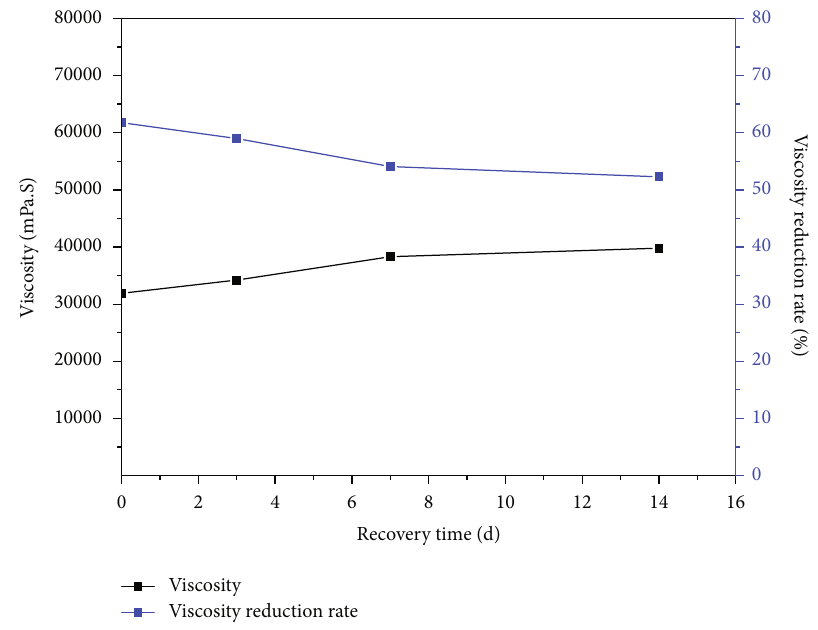
Figure 9: Viscosity and viscosity reduction rate curve changes with recovery time after reaction. Table 2: Experimental heating rate under di ff erent moisture